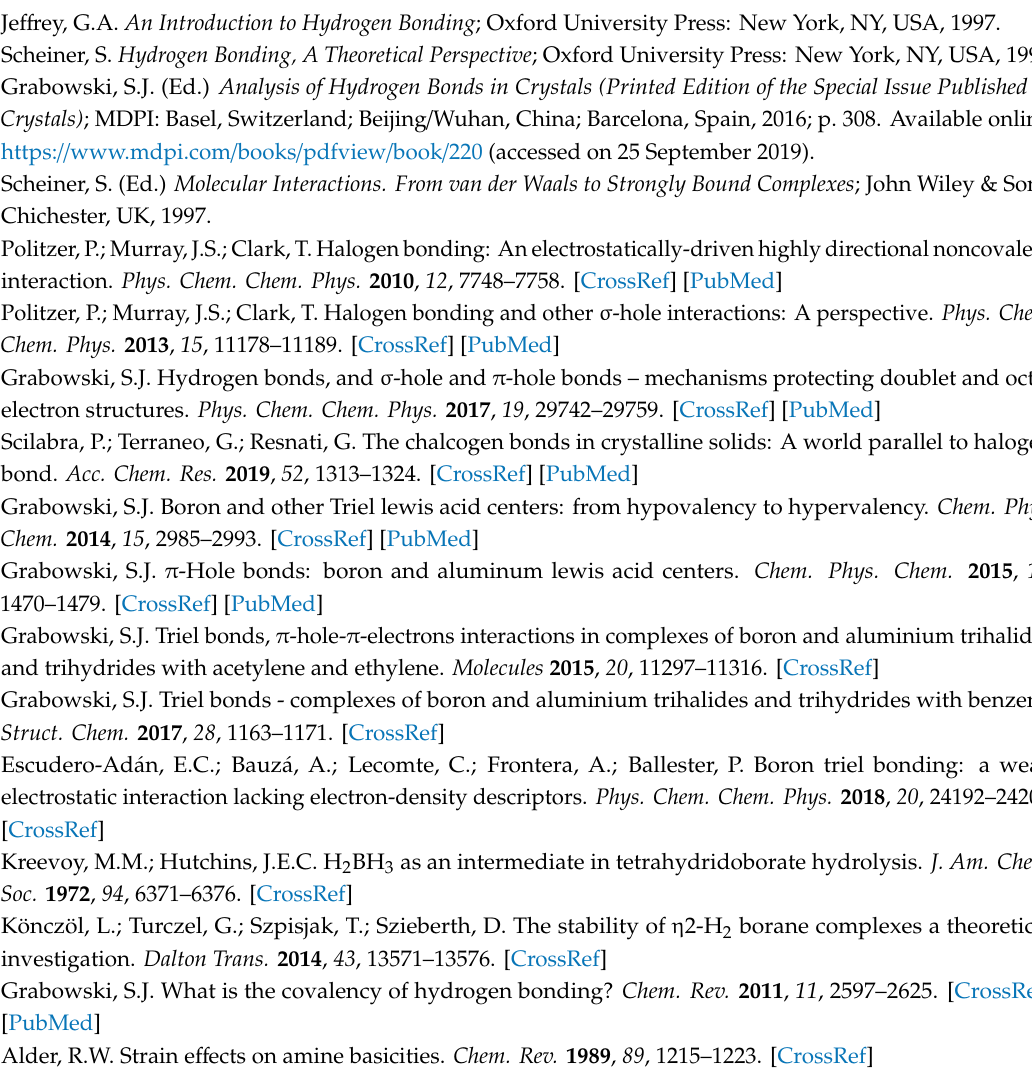
Figure S6: The fragment of the crystal structure of triphenylcarbenium B,B’-(chloro)-3,4,5,6-tetrafluoro- 1,2-bis (bis(pentafluorophenyl)boryl)benzene (refcode IQAJOZ01); Table S1: Geometrical (Å and degrees) parameters corresponding to MP2 / aug-cc-pVTZ and DFT-ADF optimizations (the latter ones in parentheses); Table S2: The T–(H / X)–T − system of hydride and halide sponges taken from the Cambridge Structural Database, geometrical parameters of systems analyzed are presented: the T ... H / X distances, (subscripts 1 and 2 correspond to two distances within one system considered) and the T–(H / X)–T angle; the refcodes of the crystal structures as well as corresponding references are included; Table S3: The T–(H / X)–T − system of hydride and halide sponges taken from Cambridge Structural Database and considered in this study; the refcodes of the crystal structures are included as well as the temperature of measurement (Temp), R-factors (residual indices) are presented and estimated standard deviations (e.s.d.s) for C–C bonds of the structure considered. Funding: This research was funded by the Spanish Government MINECO / FEDER, grant number CTQ2016-80955-P and Eusko Jaurlaritza, grant number GIC